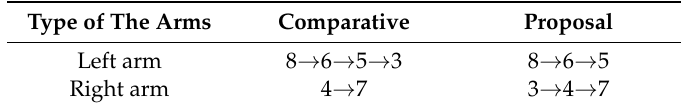
Table 4. Solution obtained from MILP based planning. MILP: mixed integer linear